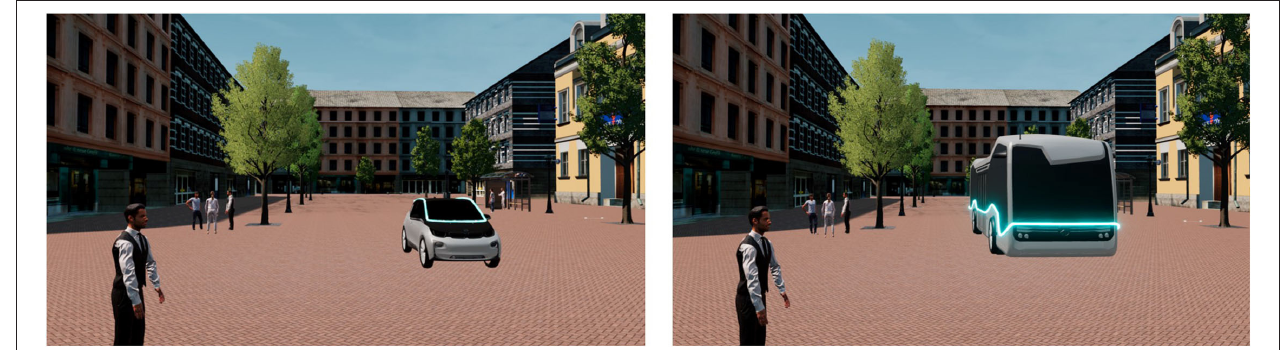
FIGURE 1 | Experimental setting of this study: The smaller AV (left) with static eHMI and the larger AV (right) with pulsating dynamic eHMI approached the pedestrian from the left-hand side on the shared space.